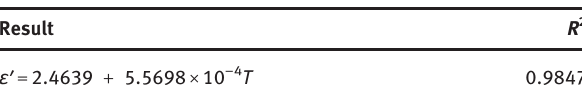
Table 2: The variation of dielectric properties of the CuCl residue with temperature.